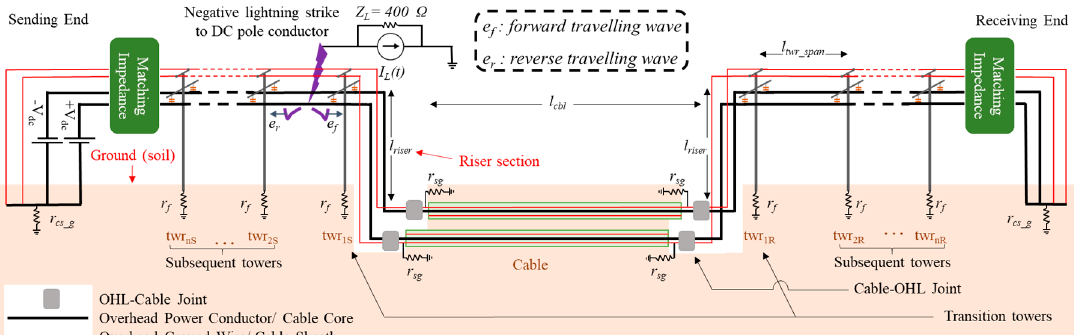
Figure 1. Fast front model of mixed High Voltage DC (HVDC) transmission line for analysis of lightning transients. A finite cable section is present between two overhead line sections terminating in matching impedance to avoid reflection of voltage surge from remote ends of the transmission line (description of symbols is provided in Table